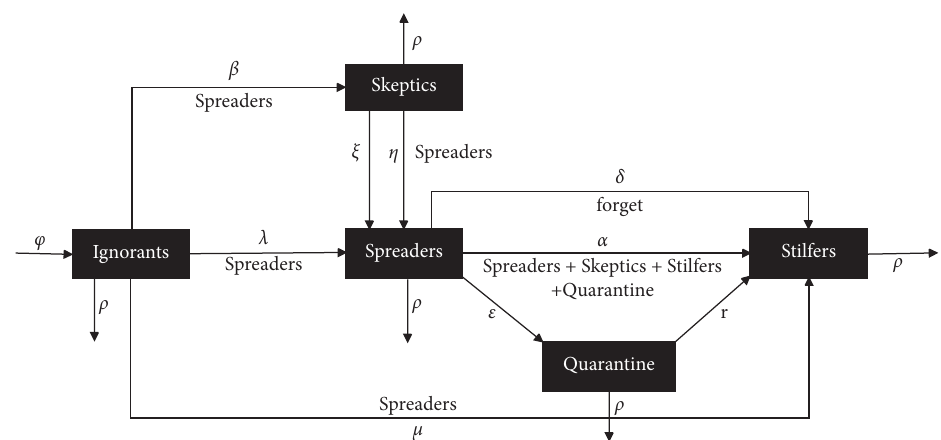
Figure 2: The transfer diagram of the SIDRQ model when adding a nonlinear